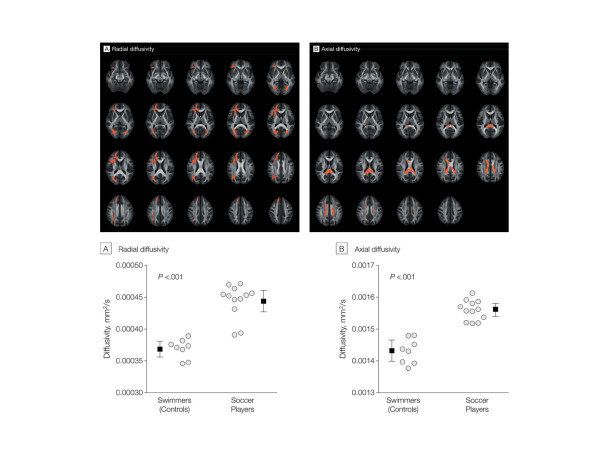
Results of the Tract-based spatial statistics analysis and diffusivity measures for individual swimmers and soccer players. Top: the diffusion tensor for each voxel was estimated by the multivariate linear fitting algorithm, and the tensor matrix was diagonalized to obtain three pairs of eigenvalues and eigenvectors. Voxelwise summary parameters included radial diffusivity and axial diffusivity. Group analyses were performed using whole-brain threshold-free cluster enhancement to obtain significant differences between groups at P < 0.05. After accounting for multiple comparisons using the family-wise error rate, the voxels highlighted in red demonstrate significantly increased radial diffusivity (A) and axial diffusivity (B) values for the soccer group compared with swimmers. Bottom: voxels with a significant group difference as revealed by Tract-based spatial statistics (top) were merged to a single cluster. Circles indicate individual values, squares indicate mean values, and error bars indicate 95% confidence intervals. Diffusivity measures were obtained for each individual and plotted for the two study groups. Linear regression showed no significant association of age or years of training with (A) radial diffusivity (P = 0.13 and P = 0.12, respectively) or (B) for axial diffusivity values (P = 0.22 and P = 0.54, respectively). Used with permission from [30].